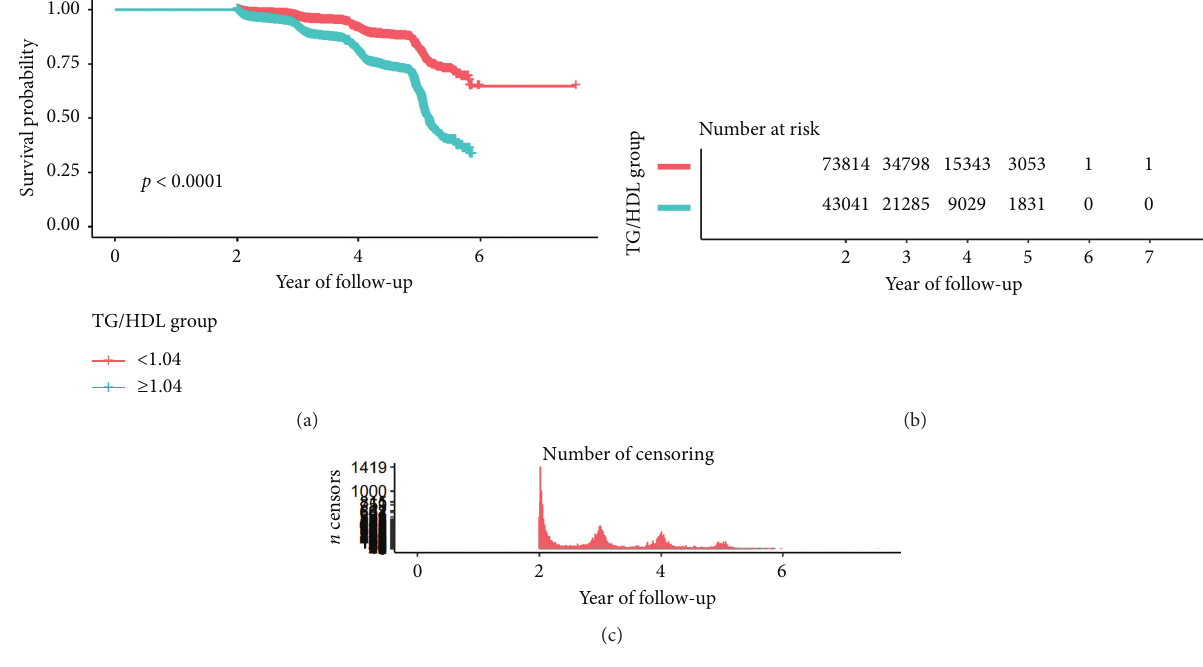
Figure 4: Survival analysis of impaired glucose tolerance with TG/HDL ratio.